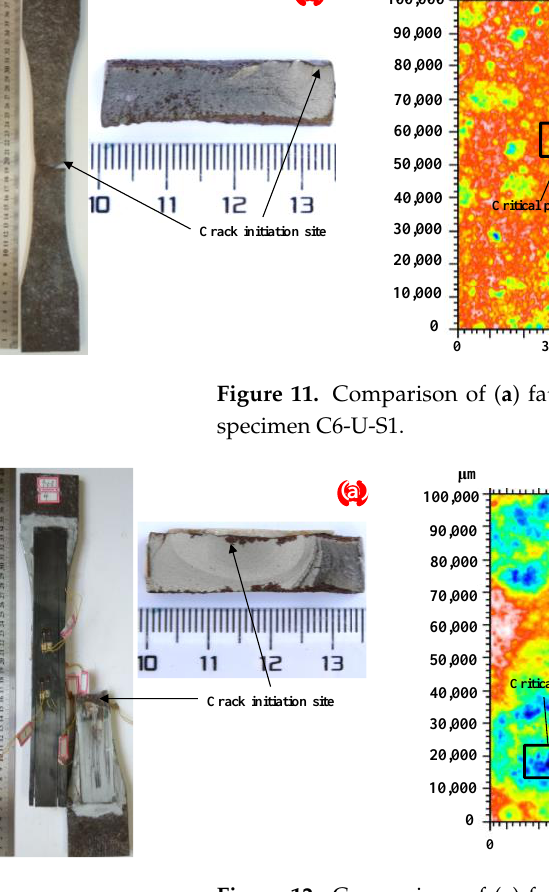
Figure 12. Comparison of ( a ) fatigue test, ( b ) 3D morphology scanning, and ( c ) FEM results of specimen